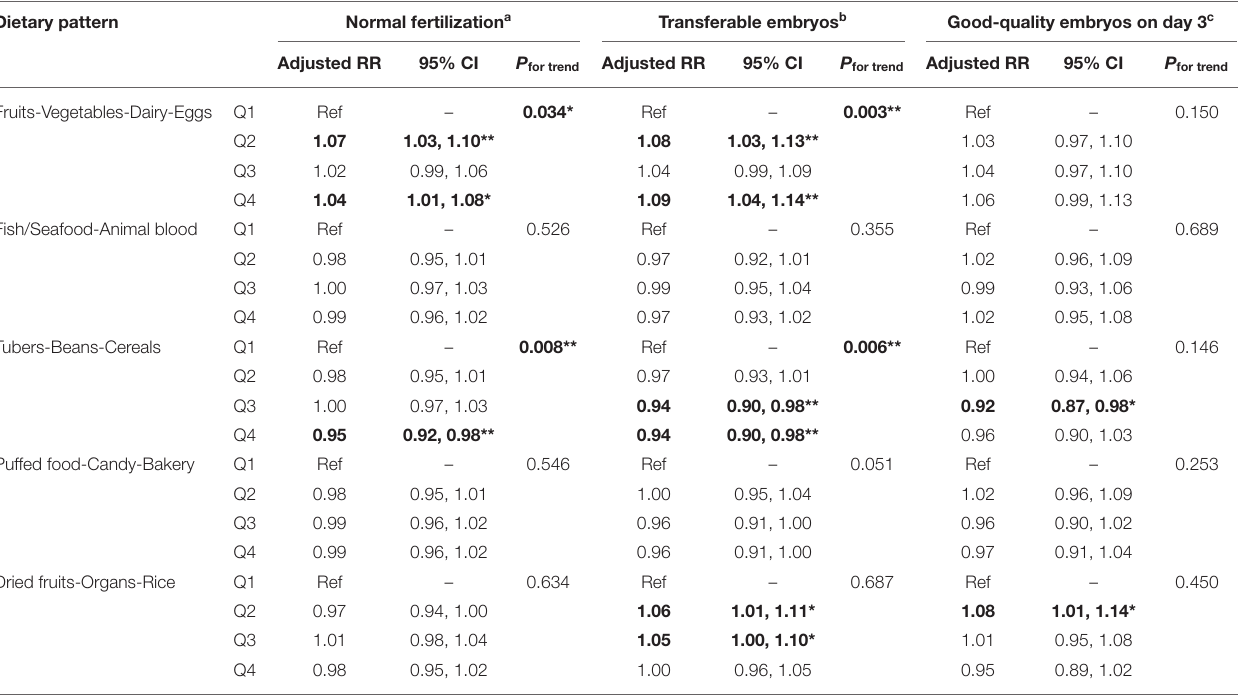
TABLE 4 | Associations of the dietary patterns derived by principal component analysis with the likelihoods of normal fertilization, transferable embryos, and good-quality embryos on day 3. Dietary